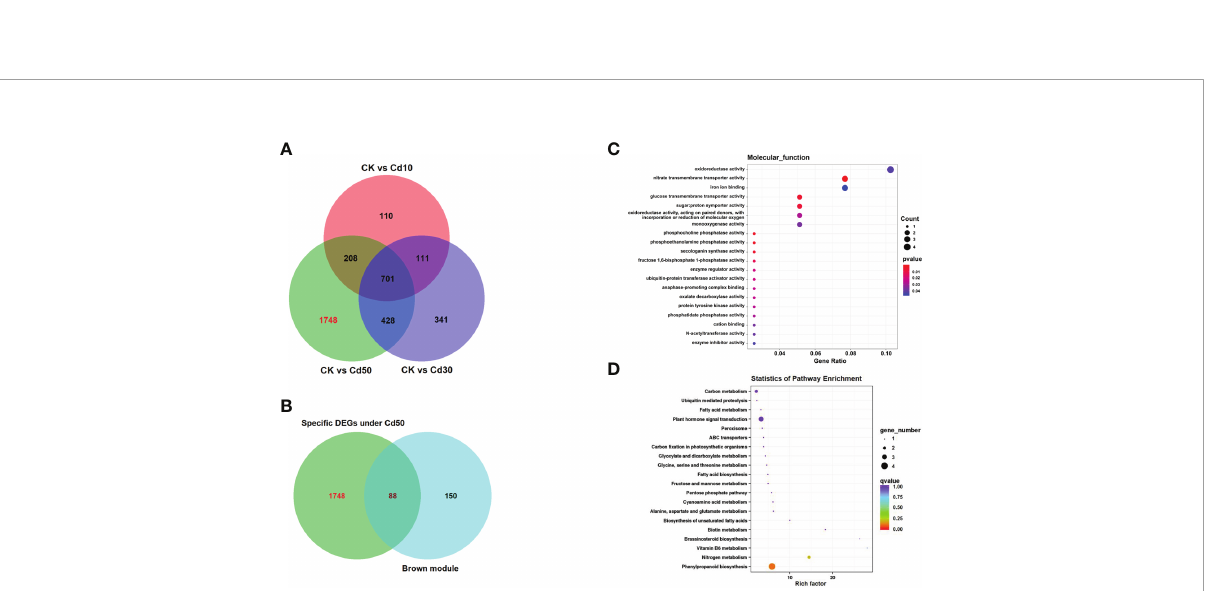
FIGURE 9 The Venn diagram, Molecular function, and KEGG (Kyoto Encyclopedia of Genes and Genomes) enrichment analyses for the hub genes induced by Cd50. (A) Venn diagram for the speci fi cally expressed genes under Cd50. (B) The 88 genes were not only speci fi cally expressed under Cd50 but also existed in the brown module. (C, D) Molecular function and KEGG analyses for 88 genes. CK, Cd10, Cd30, Cd50 indicates the Cd concentration 0 mg/L, 10 mg/L, 30 mg/L, and 50 mg/L, respectively. DEGs indicates differentially expressed genes.